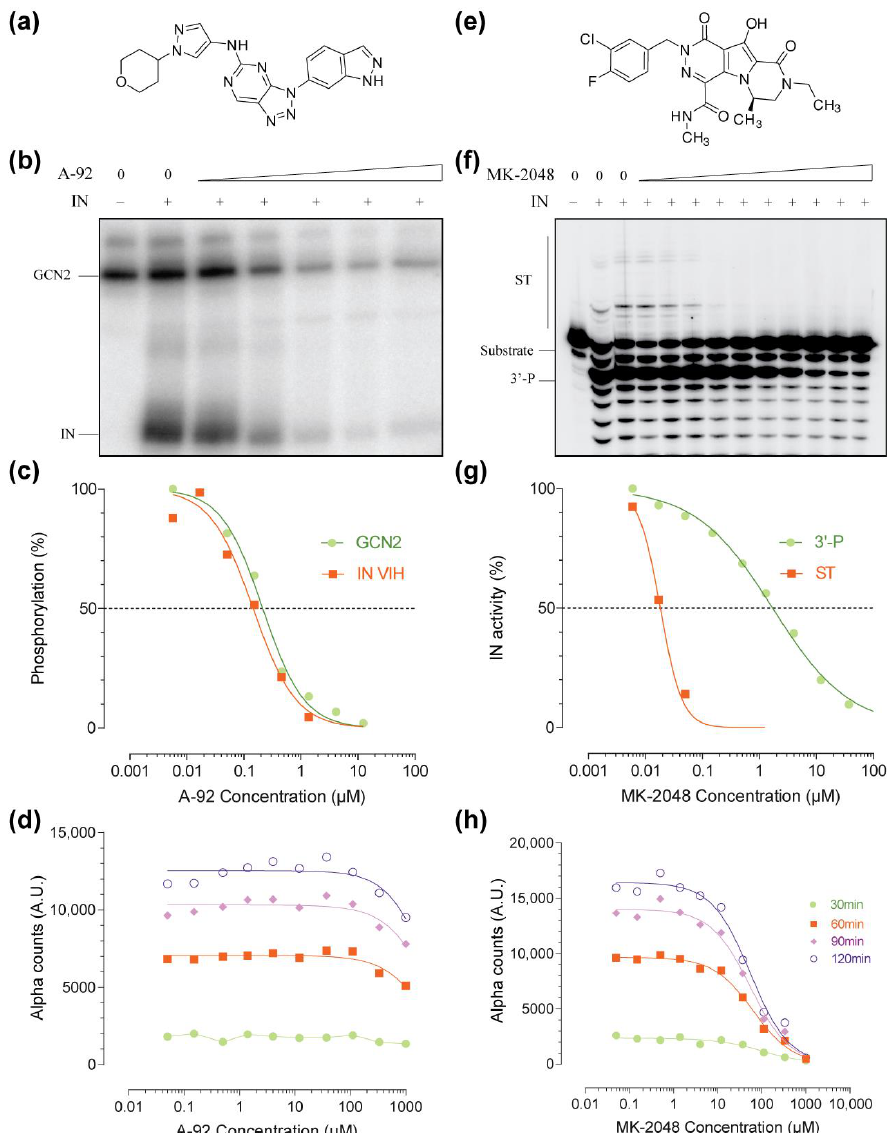
Figure 2. Effect of active site inhibitors on proteins’ activities and interaction. Chemical structure of A-92 ( a ) and MK-2048 ( e ); autoradiography of a representative in vitro phosphorylation assay ( b ) or integration assay ( f ) using increasing con- centration of active site inhibitors. Concentrations of A-92 and MK-2048 were from 3.7 µM to 45.7 nM and from 111 µM to 5.6 nM, respectively, using a 3- fold serial dilution. Quantification of GCN2’s activation (auto -phosphorylation) and phosphorylation of IN ( c ) and quantification of the 3′ -P and ST activity ( g ) in the presence of increasing concentrations of inhibitor. Monitoring of the IN – GCN2 interaction over time in the presence of increasing concentrations of A-92 ( d ) or MK-2048 ( h ).